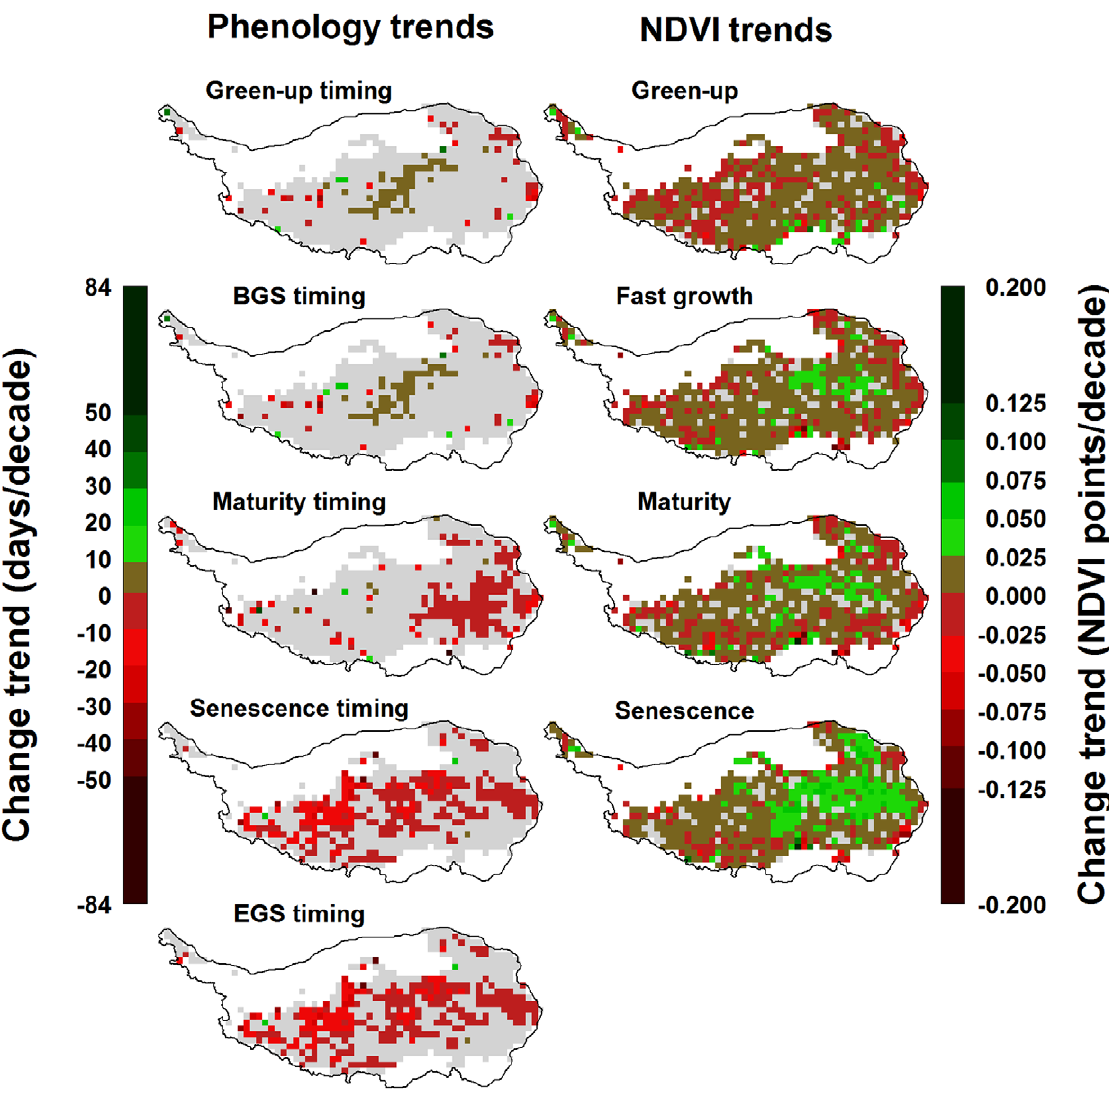
Figure 6. Trends in phenological dates (left) and NDVI (right) on the Tibetan Plateau between 1982 and 2006. Gray areas indicate regions, for which no significant trends were detected by the Mann-Kendall test at p , 0.1.